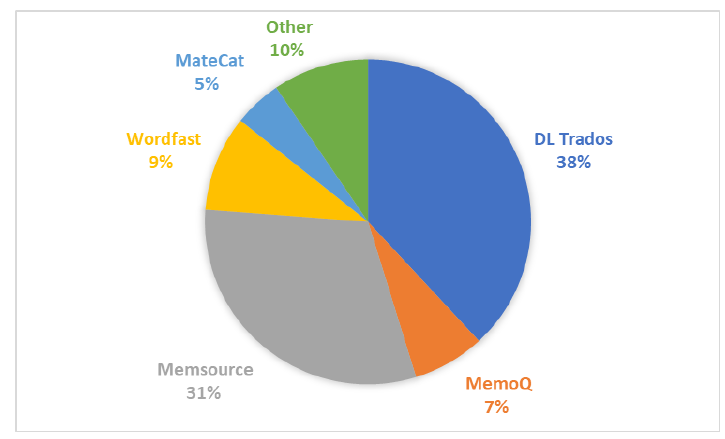
Figure 1. Computer-assisted translation (CAT) tools that are extensively used among participants.